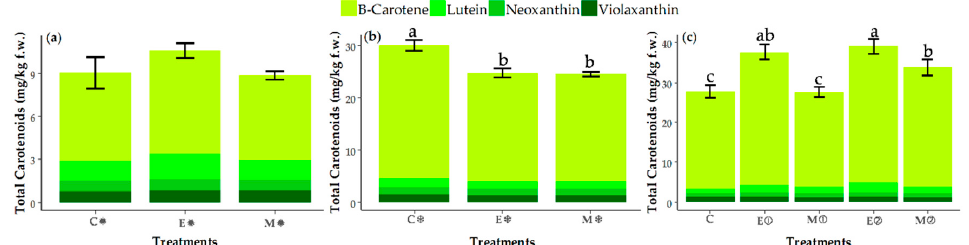
Figure 2. Content of individual carotenoids ( β -carotene, lutein, neoxanthin and violaxanthin) (mg/kg f.w.) analyzed by HPLC-DAD, using samples of broccoli florets of the spring assay ( a ) (C (cid:89) , E (cid:89) , M (cid:89) ), autumn assay ( b ) (C (cid:102) , E (cid:102) , M (cid:102) ) and dosage assay ( c ) (C, E (cid:192) , M (cid:192) , E (cid:193) , M (cid:193) ): C (control), E (excipient), M (MeJA), (cid:89) (spring), (cid:102) (autumn), (cid:192) (one application MeJA) and (cid:193) (two applications MeJA). Values are expressed as the mean ± SD. Di ff erent letters ( a – c ) indicate significant di ff erences ( p < 0.05) among the samples of each assay in terms of total carotenoids ( n =